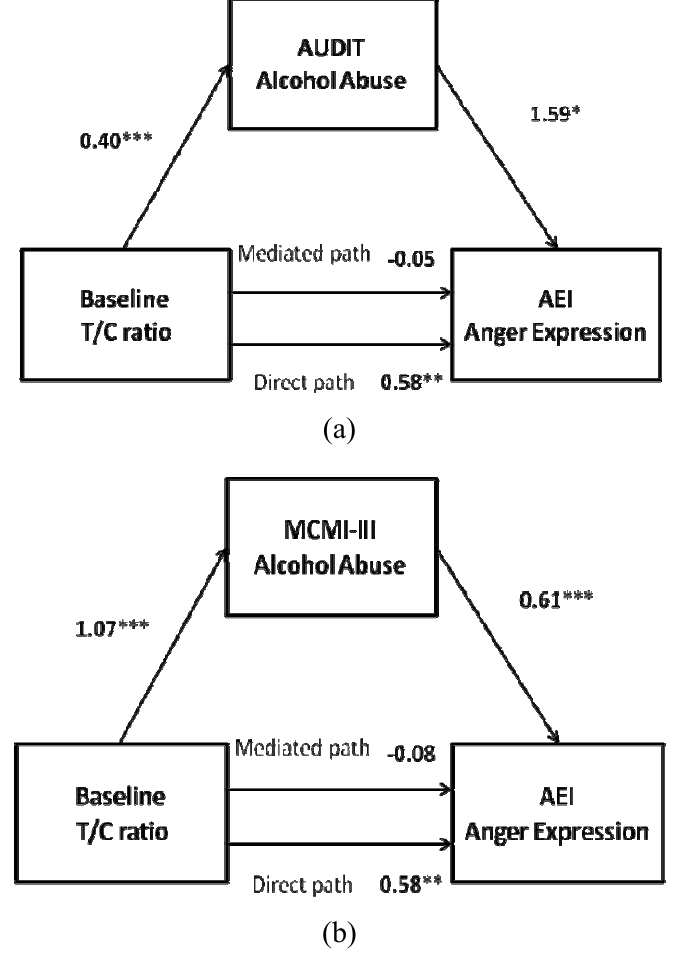
Figure 1. Baseline testosterone/cortisol (T/C) ratio as a predictor of ( a ) anger expression index (AEI) anger expression mediated by Alcohol Use Disorders Identification Test (AUDIT) alcohol consumption and ( b ) by Millon Clinical Multiaxial Inventory-III (MCMI-III) alcohol abuse in intimate partner violence (IPV) perpetrators. * p < 0.05, ** p < 0.01, *** p <